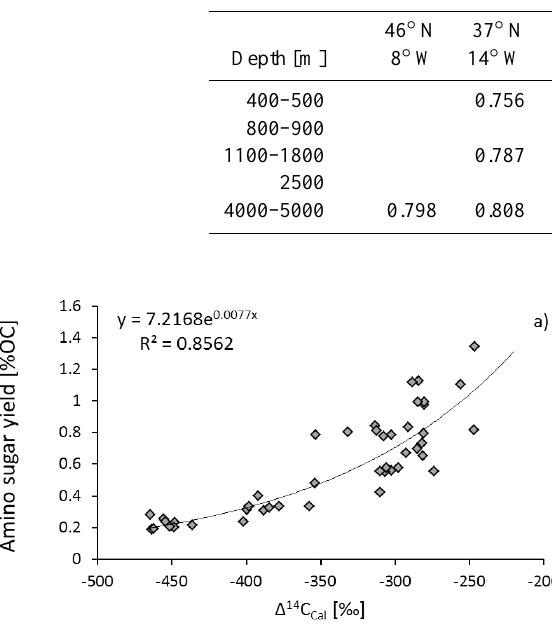
Table 3. I DEG values for deep water layers.